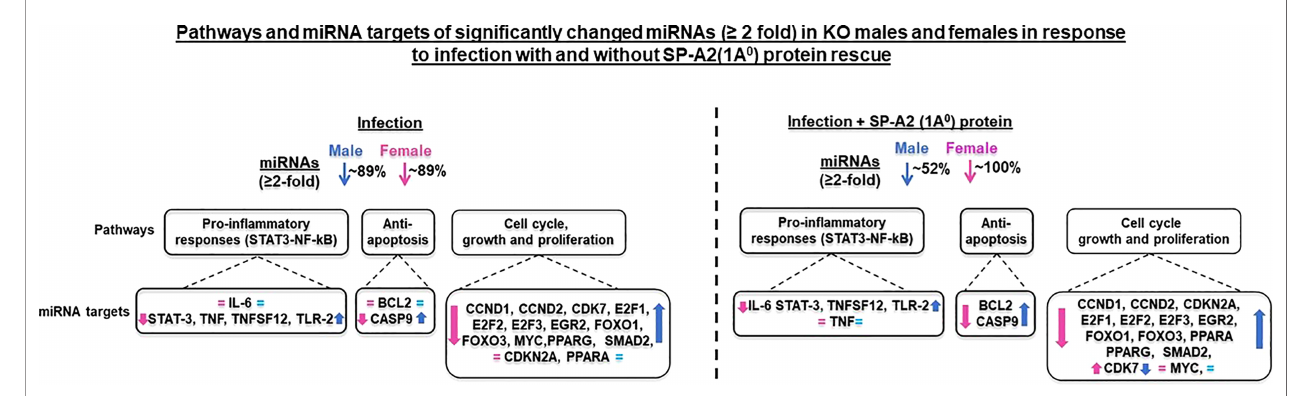
FIGURE 2 | Effect of infection and infection plus SP-A2 (1A 0 ) protein rescue on the miRNome, miRNA-mRNA targets, and pathways of the LAC KO male and female mice. A comparison is shown of the miRNAs, target genes, and pathways of the LAC KO after infection and infection plus SP-A2 (1A 0 ) rescue in the left and right panels, respectively. The signi fi cantly regulated miRNAs (n = 19) each present in KO male and female groups in response to infection were largely decreased by ~89% in male (blue arrow) and female (pink arrow) mice. In the infection plus SP-A2 (1A 0 ) protein rescue, ~52% of the signi fi cantly regulated miRNAs (n = 19) were decreased in male (blue arrow) and 100% in female (pink arrow) mice; a few miRNAs showed an increase (Table 1) ). Three pathways are depicted as assessed by IPA of the signi fi cantly changed miRNAs. The upregulated miRNA-mRNA targets in KO male mice (blue arrow) and the downregulated targets in female mice (pink arrows) are depicted after infection and infection plus rescue in the left and right panels, respectively. The mRNA targets that did not change after infection and infection plus SP-A2 (1A 0 ) protein are shown in pink and blue equal